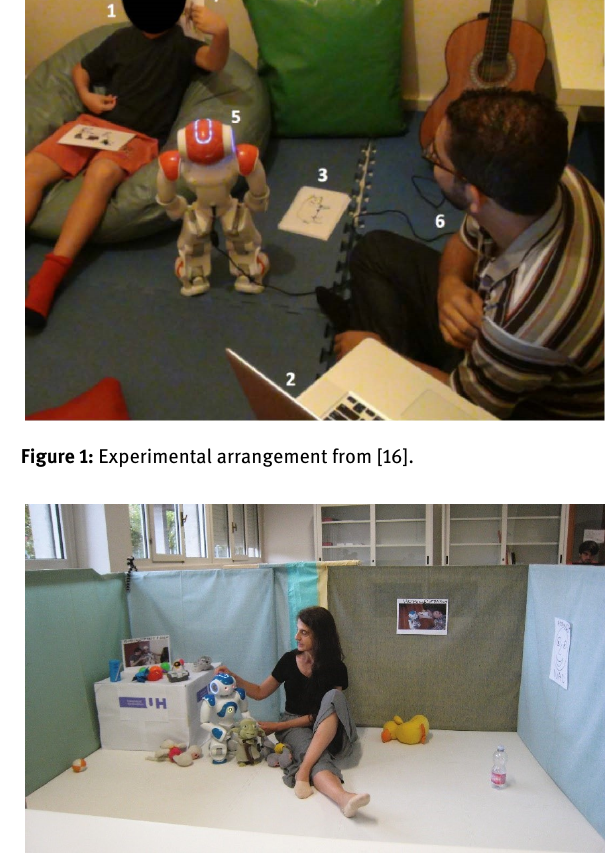
Figure 2: Experimental arrangement from [17].